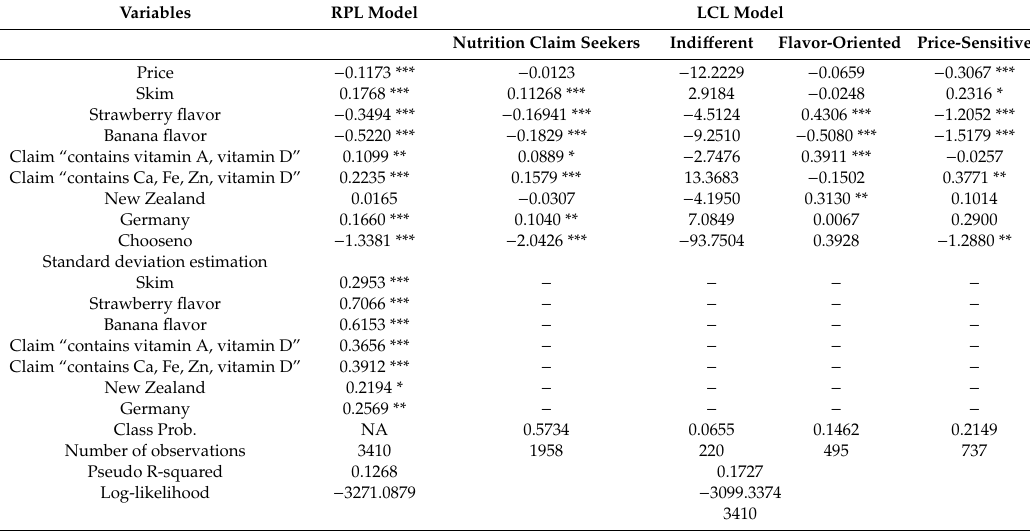
Table 3. Estimation results of RPL and LCL